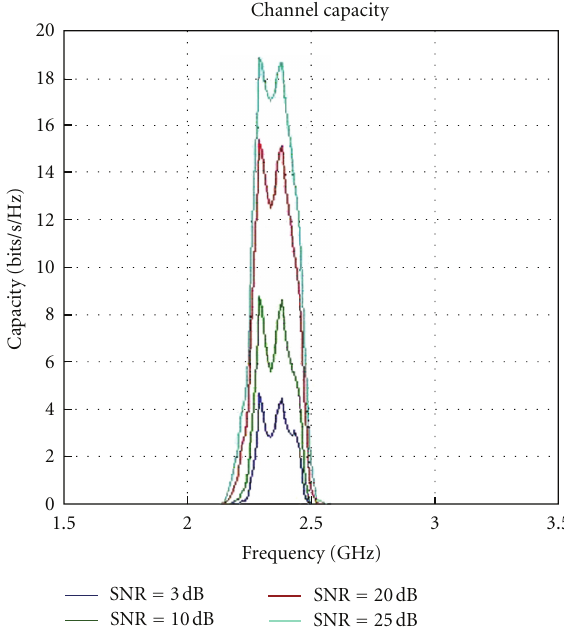
Figure 21: 3 antennas on the edges—calculated channel capacity (from channel transfer